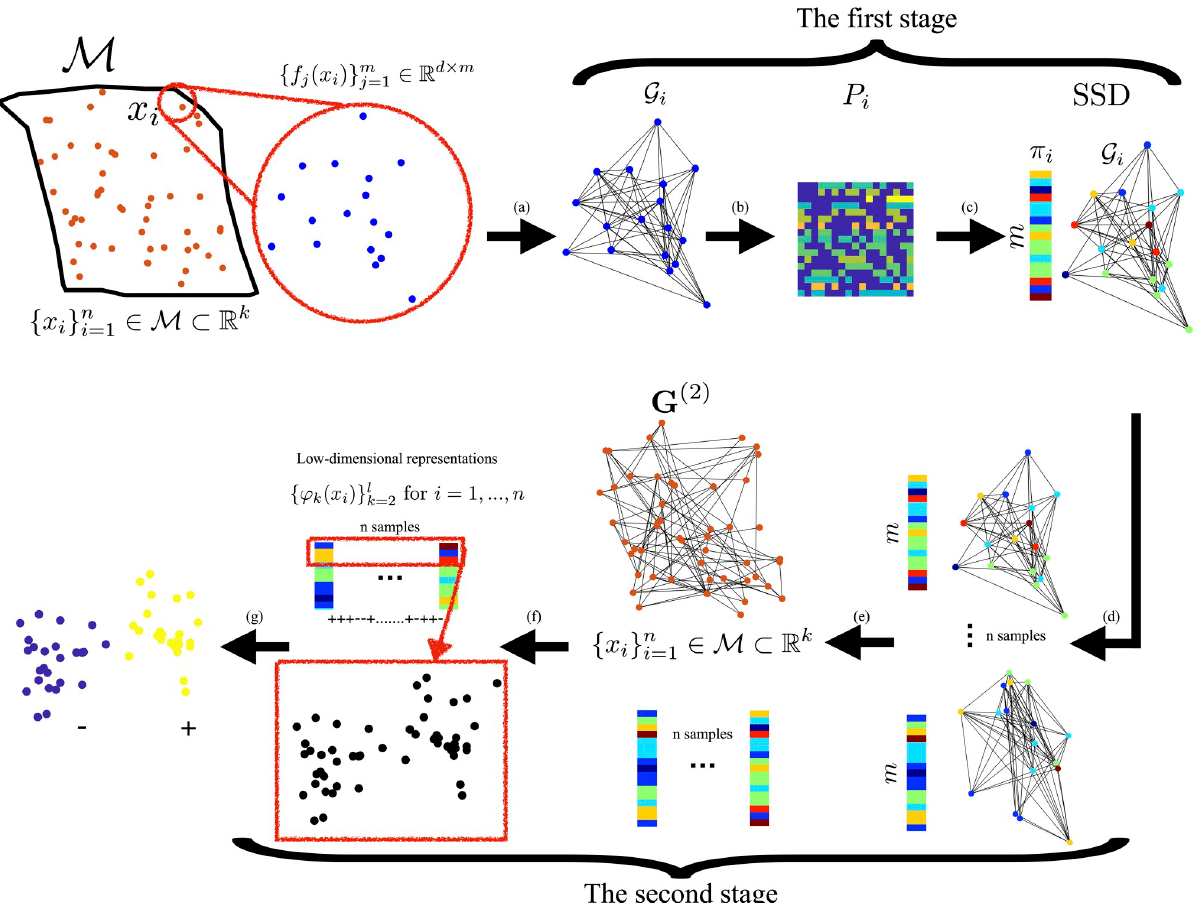
based on its multi-feature observations i on G . (c) We extract the SSD signature π from P . (e) We collect the i i i i